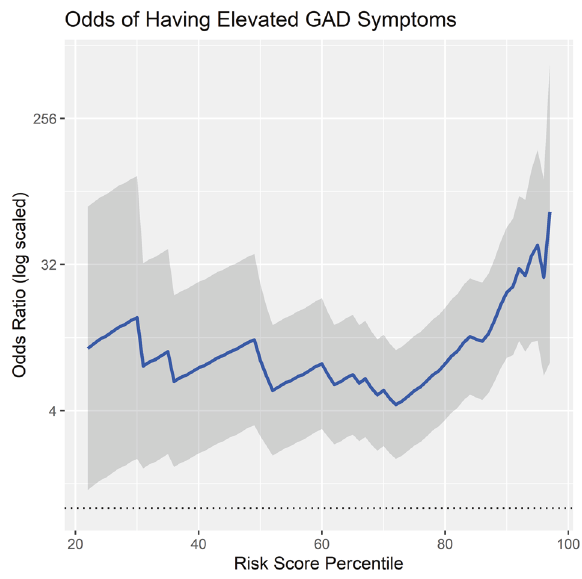
Fig. 3 This plot depicts the odds of having elevated GAD symptoms (de fi ned as greater than 1 standard deviation above the population mean in GAD symptoms) at varying levels of risk scores. The gray lines depict the 95% con fi dence intervals of the odds